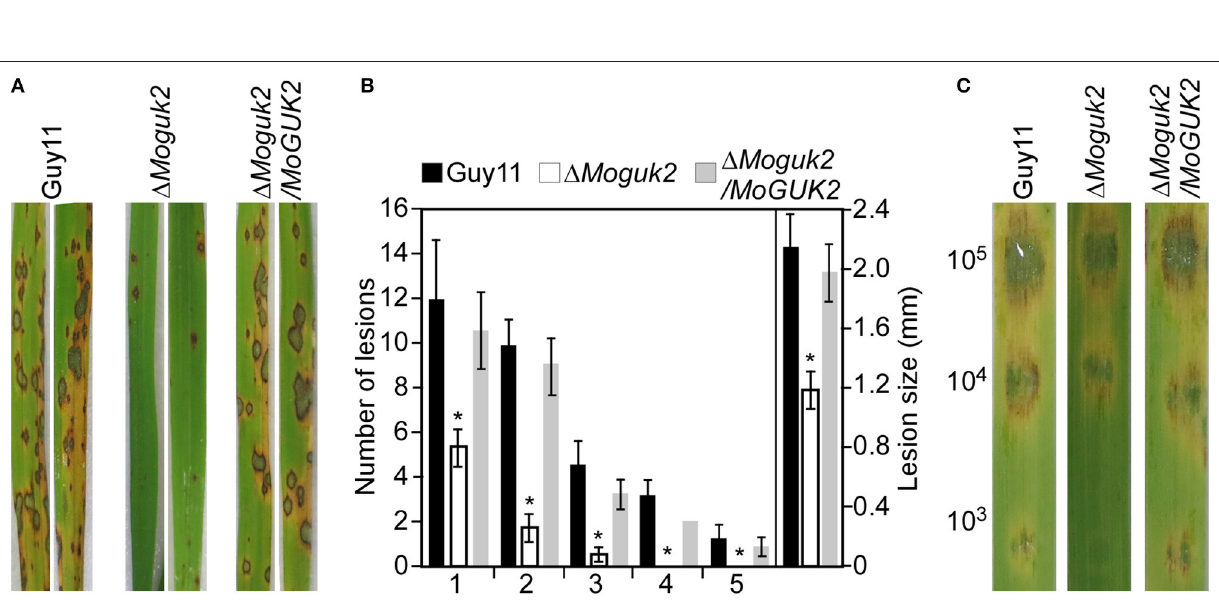
Frontiers in Microbiology |